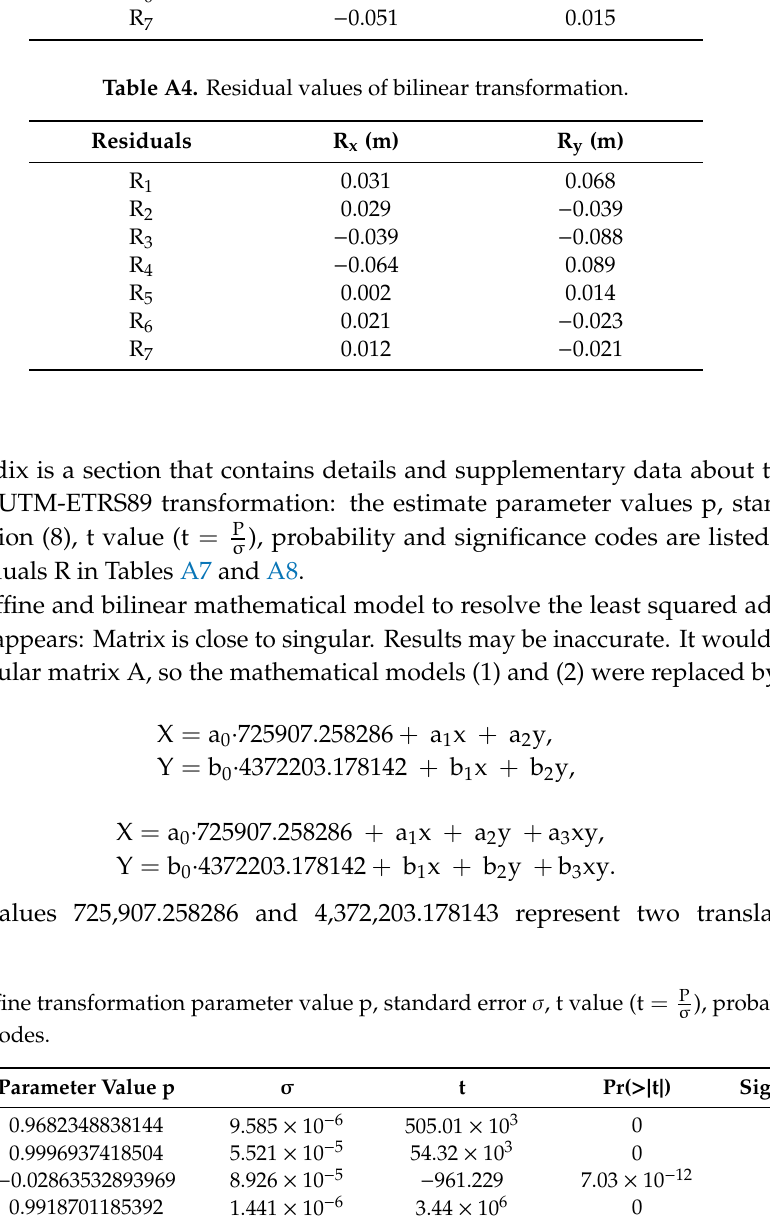
σ ), probability and